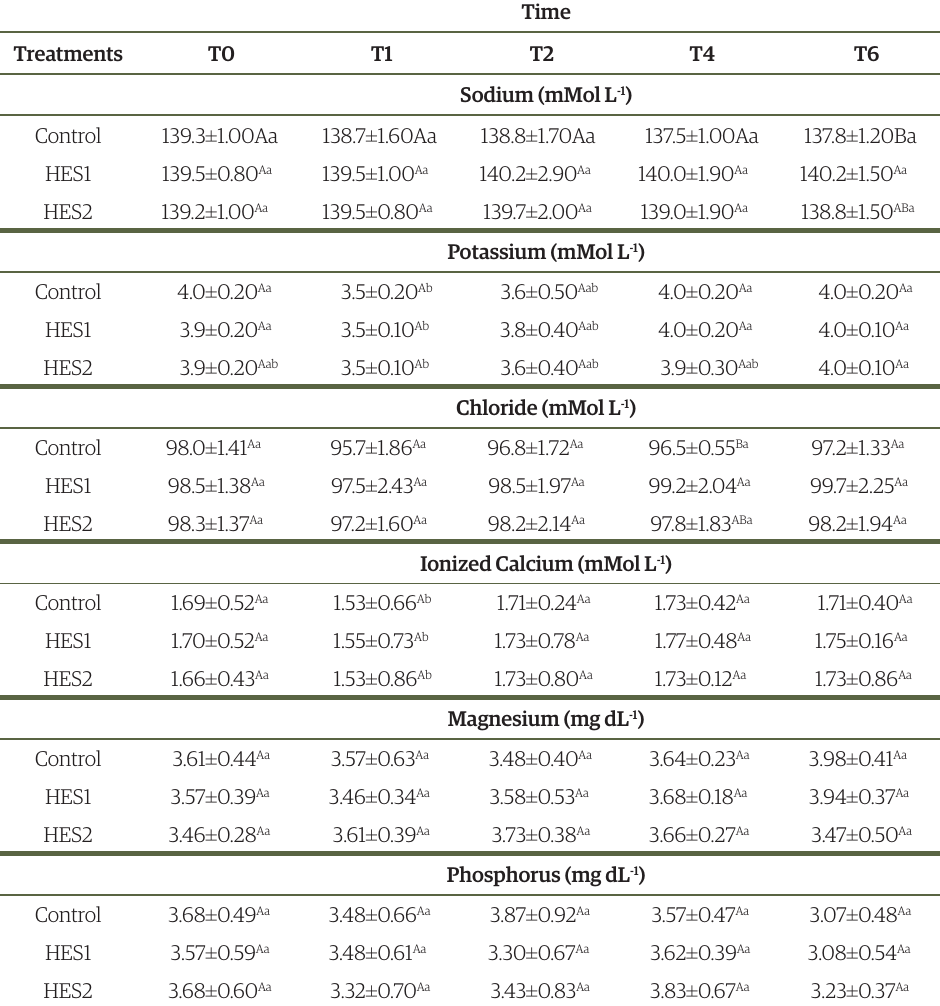
table 2. Mean values and standard deviations of the electrolytes sodium (mMol L -1 ), potassium (mMol L -1 ), chloride (mMol L -1 ), ionized calcium (mMol L -1 ), magnesium (mg dL -1 ), and phosphorus (mg dL -1 ) of healthy horses before (T0) and after (T1) gait training for one hour and subsequently treated with water (control) or with hydroelectrolytes and energy replenishers (HES1 and HES2) ad libitum for six hours (T2, T4, T6) in a 6x3 cross-over